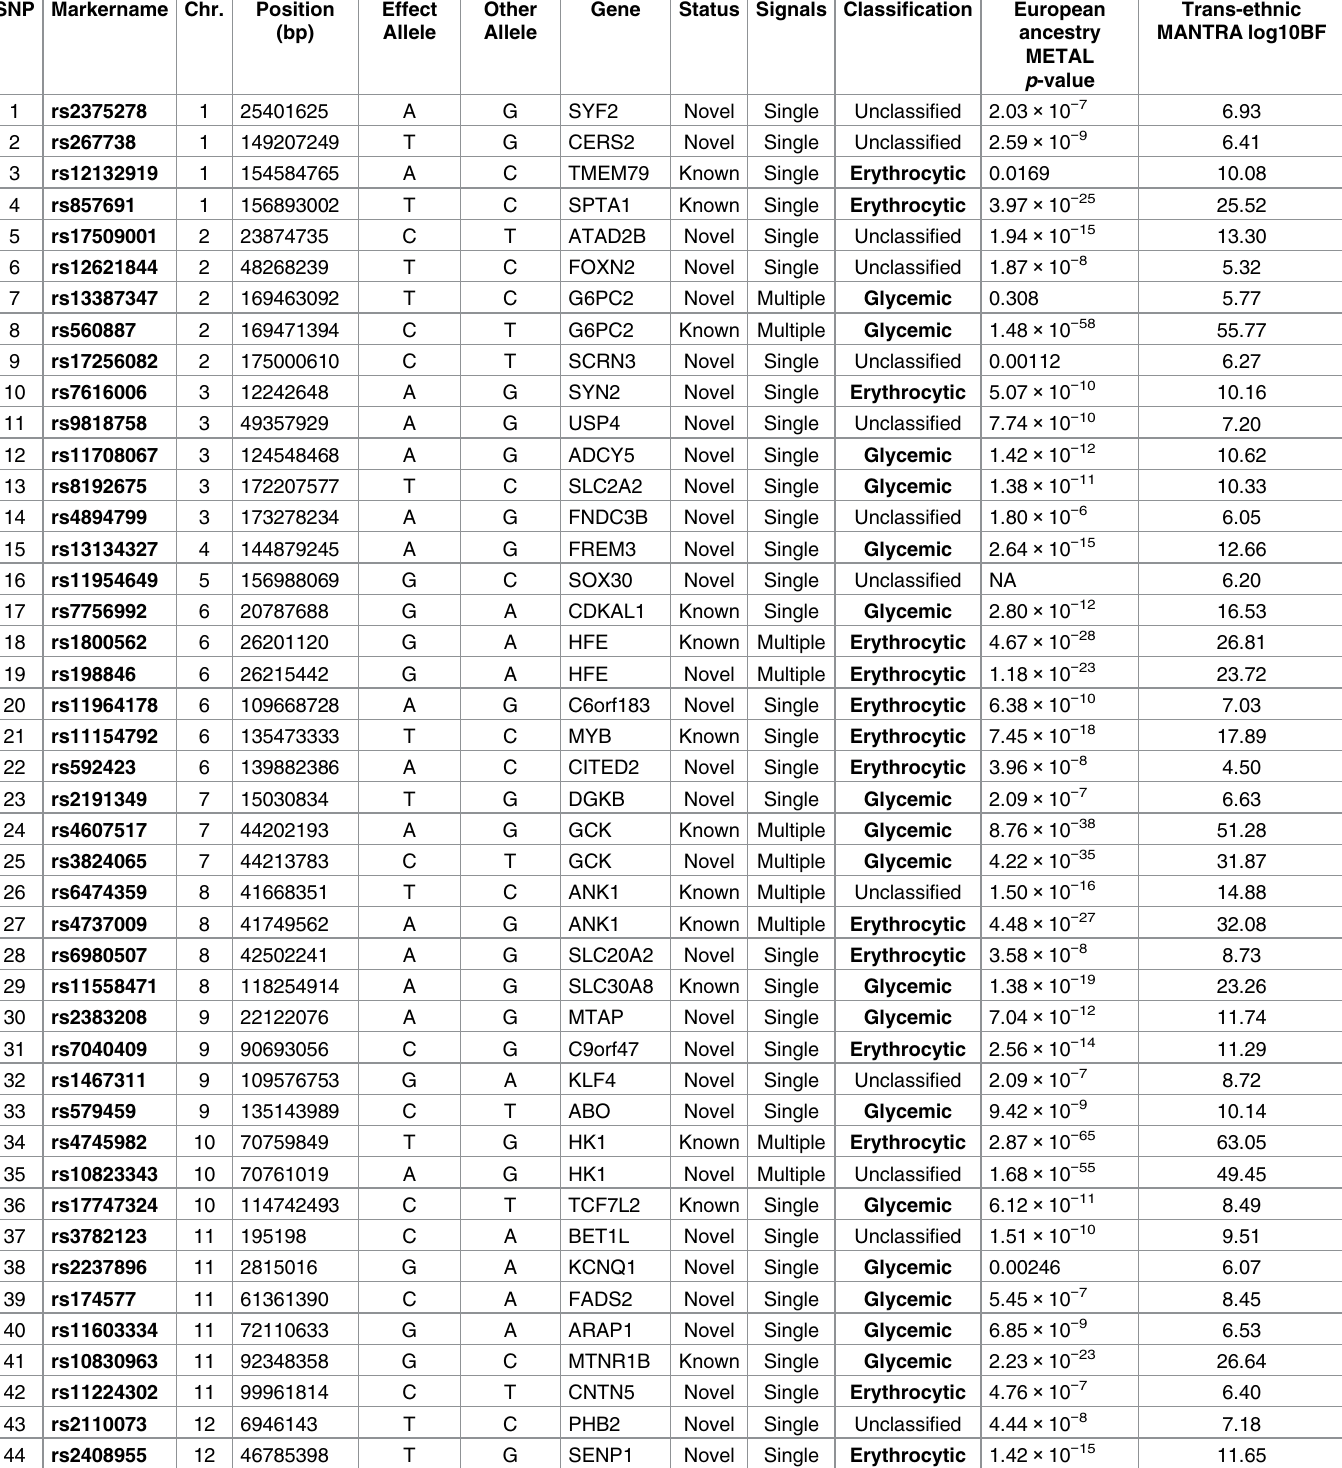
Table 1. Table of HbA1c associated variants. Table with results and classification of the 60 HbA1c-associatedvariants. SNP number corresponds to num- ber in Fig 1. SNP Markername